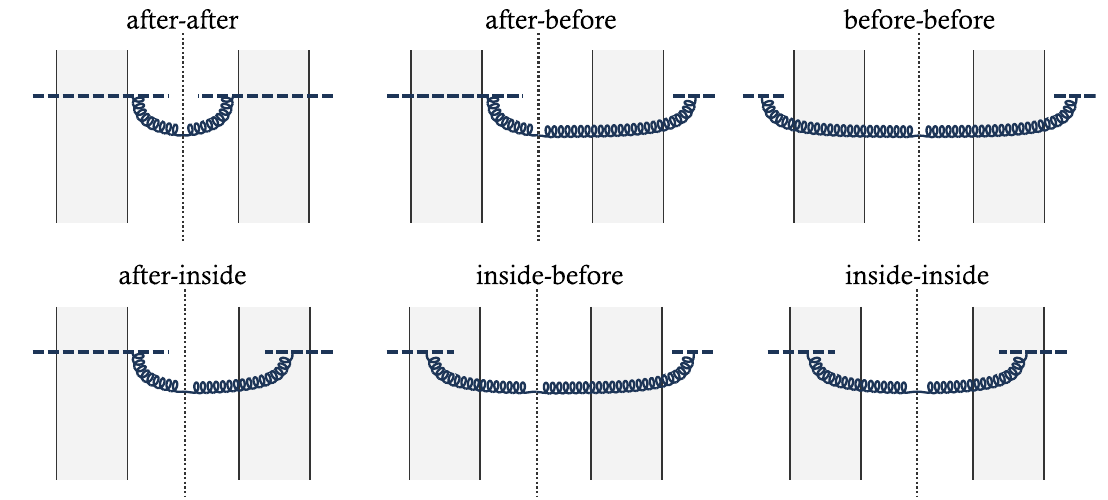
Fig. 2 All possible contributions to the single gluon spectrum given in Eq. (4.6), which result from squaring the amplitude of a gluon being emitted before, during (inside) or after the interaction of the source with the target